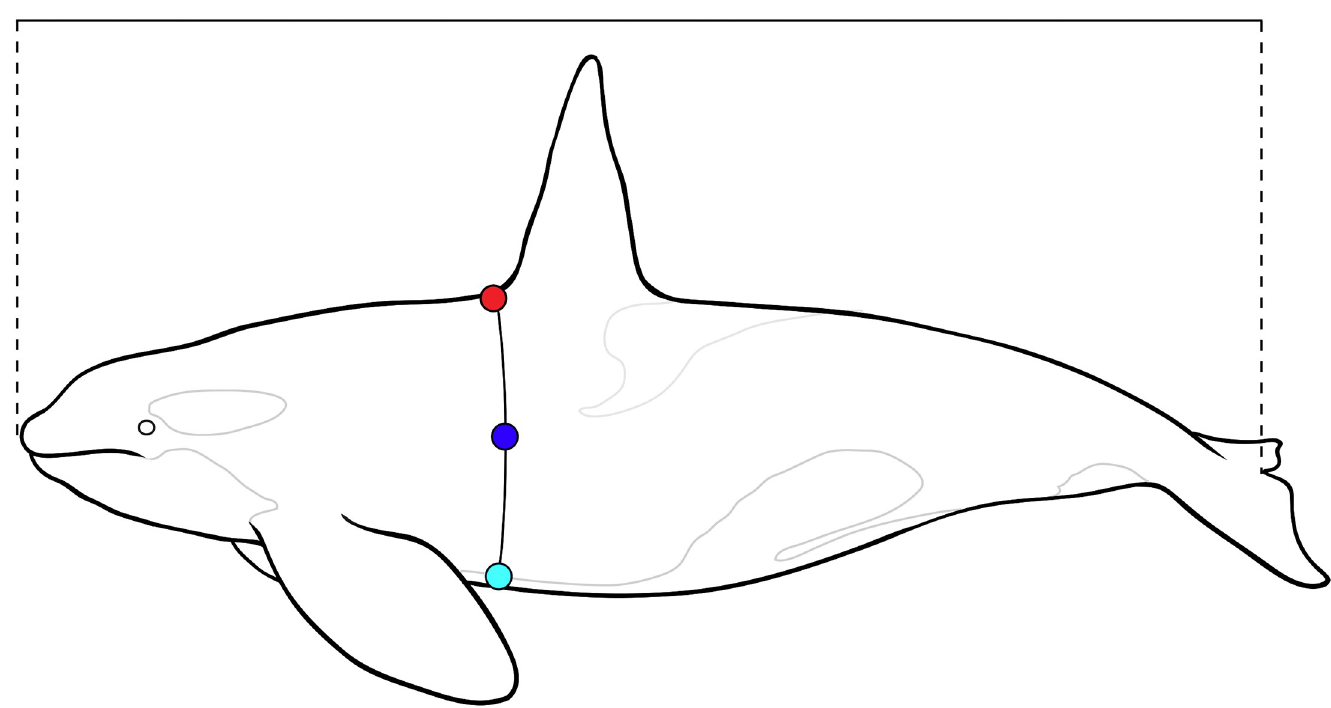
Fig 1. Morphometric measurements taken from stranded killer whales at necropsy to assess body condition. Total straight body length (solid line above whale), girth at the anterior insertion of the dorsal fin (solid line) and blubber thickness measured with a ruler at three sites: dorsal (red), lateral (dark blue), and ventral (light blue) are